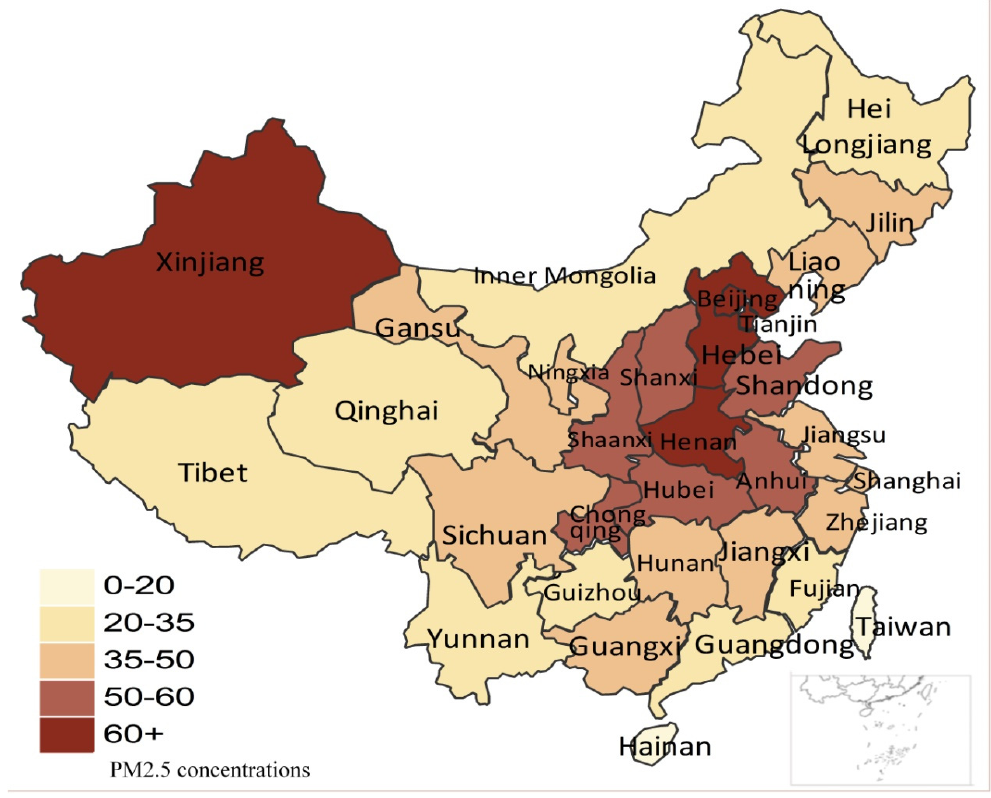
Figure 1. PM 2.5 concentrations of 31 Chinese provinces in 2016.